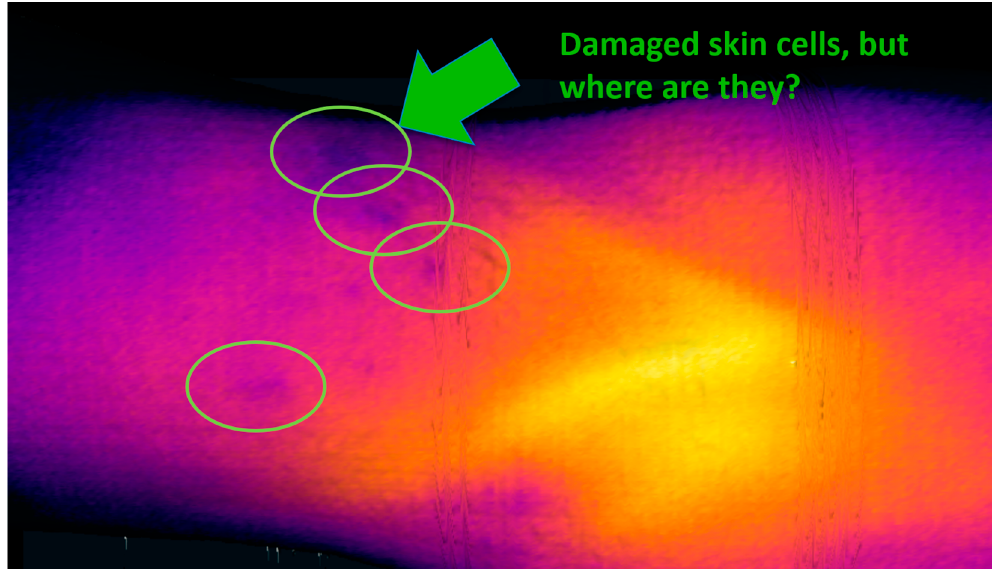
Figure 2. The thermal footprints cannot be clearly assigned to particular locations on the body. The lack of sharp edges and other spot landmarks makes exact localization in a single 2D thermal image impossible unless registration is performed with such a supplementary layer that yields clear features.